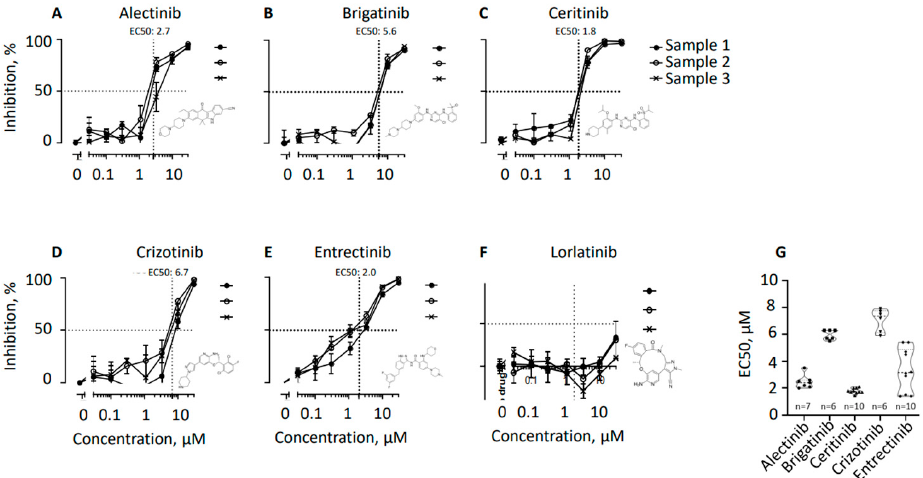
Figure 1. Inhibition of CD19-positive B lymphocyte populations proliferation expressed as a per- centage normalized to mock-treated controls. The efficiency of tyrosine kinase inhibitors alectinib ( A ), brigatinib ( B ), ceritinib ( C ), crizotinib ( D ), entrectinib ( E ), and lorlatinib ( F ) was measured using incorporation of H3-Thymidine by B lymphocytes as counts per minute (CPM). Three representative samples from three healthy donors (1, 2, and 3) are shown. The values were first normalized to the mock-treated controls that are taken as “1”. Inhibition was then calculated as: “Inhibition = 1 − normalized CPM”. Thus, lack of inhibition in mock-treated cells is expressed as 1 − 1 = 0 (0% inhibition), while lack of radioactivity was taken as a total inhibition and resulted in 1 − 0 = 1 (100% inhibition). The experiment was performed at least 6 times with selected inhibitors, i.e., with alectinib ( n = 7), brigatinib ( n = 6), ceritinib ( n = 10), crizotinib ( n = 6), entrectinib ( n = 10), and lorlatinib ( n = 7). ( G ) Summary of six to ten experiments, as indicated, showing distribution of values. Average ± SEM is as follows: alectinib (2.5 ± 0.2), brigatinib (6.0 ± 1.5), ceritinib (1.8 ± 0.1), crizotinib (7.1 ± 0.3), entrectinib (3.4 ± 0.5). The table containing experimental data for each experiment are available in the Supplementary information (Figure S3). Each data point represents an individual donor